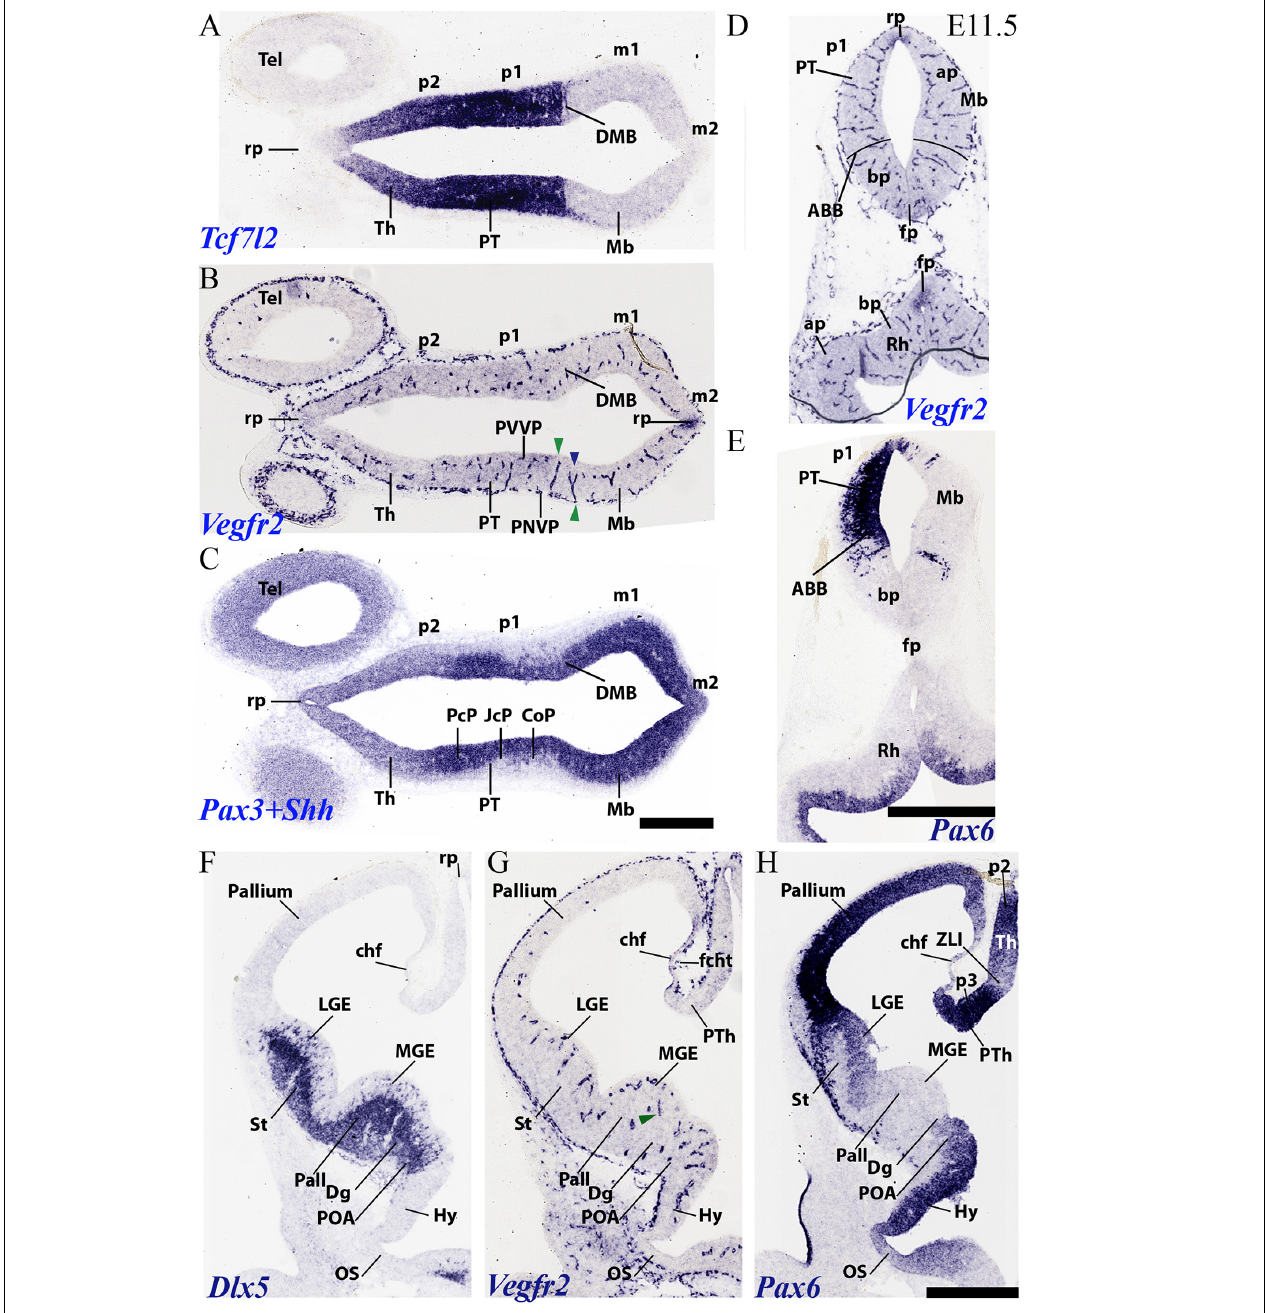
FIGURE 7 | Horizontal (A–C) and transversal (D–H) sections through embryonic mouse alar forebrain at E11.5 showing PNVP vascularization, perforant vessels and PVVP formation (Vegfr2; B,D,G ), compared in consecutive sections with various markers of the alar forebrain (Tcf7l2: A ; Pax3+Shh: C ; Pax6: E,H , and Dlx5: F ). (A–C) Horizontal sections displaying diencephalic neuromeres p2 (Th) and p1 (PT) and midbrain (Mb), jointly with dorsal part of telencephalic vesicle (Tel), in order to observe segmental differences in degree of alar vascularization. (D,E) Consecutive transversal sections passing through the midbrain-diencephalic border (left side = PT; right side = Mb), and showing also a hindbrain cross-section underneath (Rh). The alar-basal boundary is indicated (ABB), as delineated by Pax6 alar signal in (E) . Green arrowheads: perforant vessels restricted radially to a specific neural histogenetic domain; blue arrowhead: a perforant vessel ramifies into PVVP within Mb, but does not invade adjacent PT. (F–H) Three consecutive cross-sections through the secondary prosencephalon (hypothalamus plus telencephalon), midways through the telencephalic vesicle, illustrating vascularization patterns (Vegfr2; G ) in the subpallium (medial and lateral ganglionic eminences, MGE, LGE; marked by Dlx5 expression in F ) and the pallium (marked by Pax6 expression in H ; Pax6 signal also appears in the preoptic area, POA). See description in the text. Scale bars: 400 µ m.